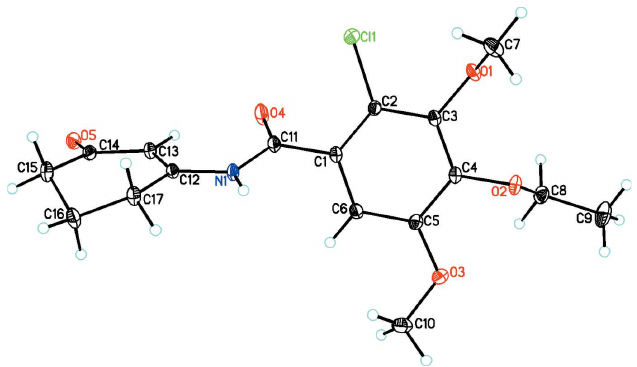
Figure 1 The molecular structure of 3a with atom labeling and with atomic displacement parameters shown at the 30% probability level.